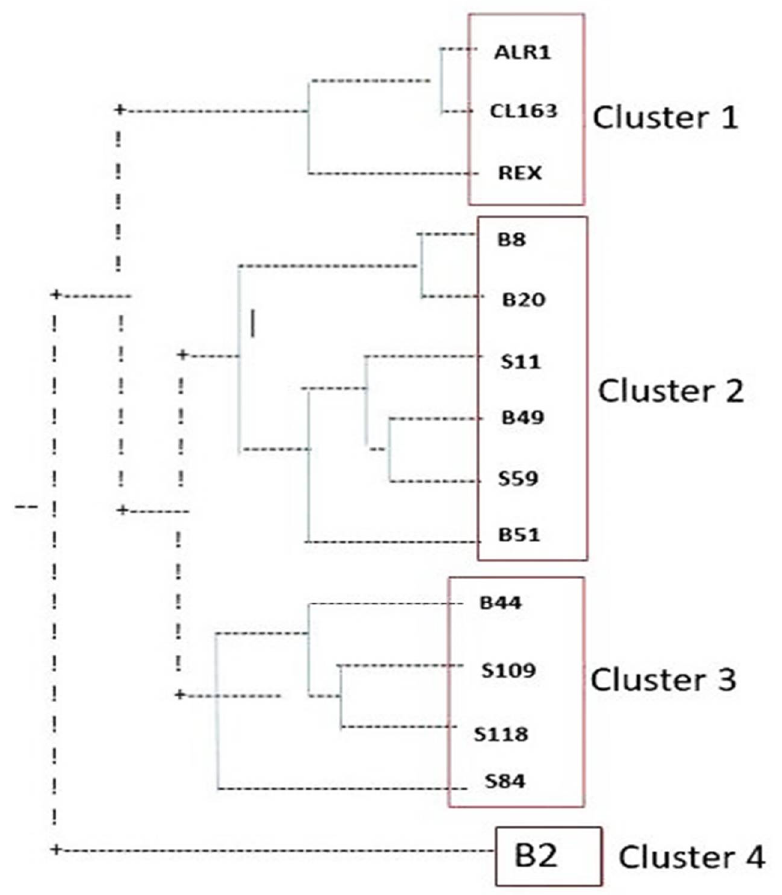
Figure 2. Dendrogram representing the relationship among the accessions with respect to herbicide tolerance. Accessions within the red box are more genetically similar as compared to accessions belonging to different red boxes, as indicated by Nei’s genetic distance.